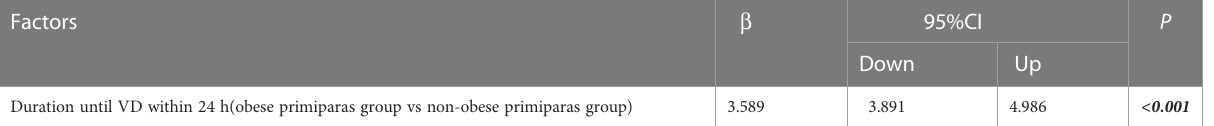
TABLE 4 Multivariable regression for duration until VD within 24 h for obese vs non-obese groups. Factors b 95%CI P